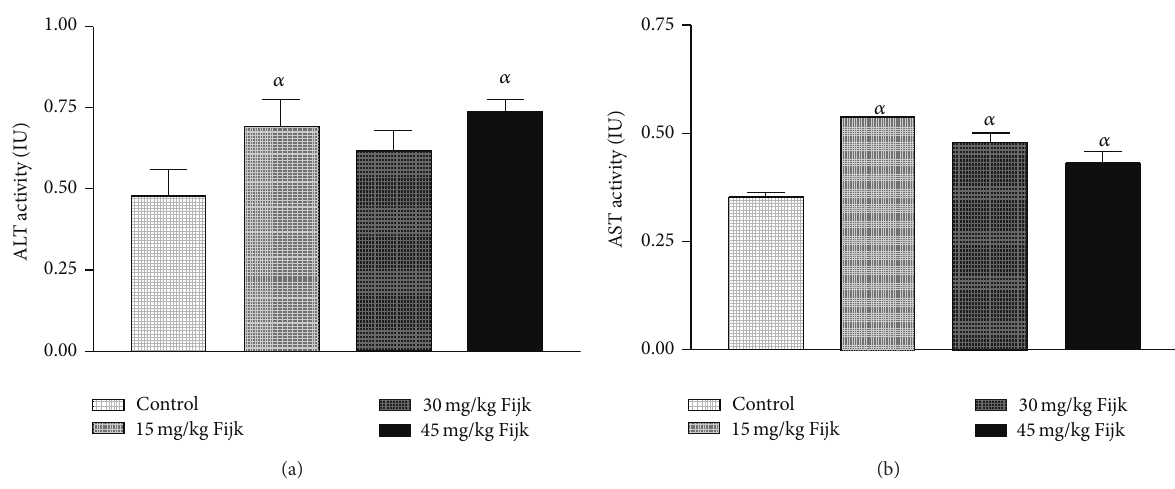
Figure 5: (a) Level of rat plasma alanine transaminase following repeated and oral exposure to Fijk herbal at different dosages; (b) level of rat plasma aspartate transaminase following repeated and oral exposure to Fijk herbal at different dosages. Data are presented as mean value ± standard error of mean (SEM), 𝑛 = 6 . 𝛼 is significant at 𝑃 < 0.05 relative to control.